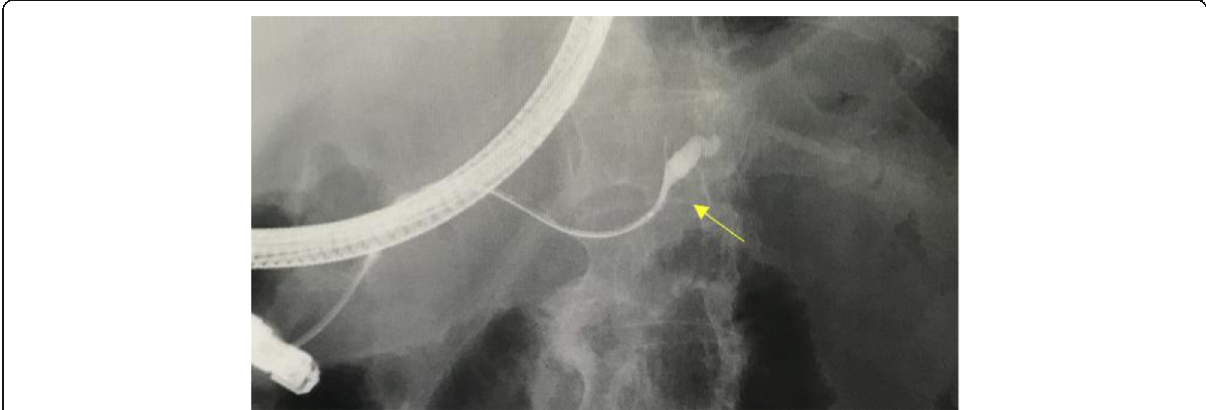
Fig. 2 Endoscopic retrograde pancreatography revealed that the main pancreatic duct was stenotic without any connection to the cystic lesion. The main pancreatic duct showed tapered stenosis at the pancreatic body and a slightly dilated main pancreatic duct on the distal